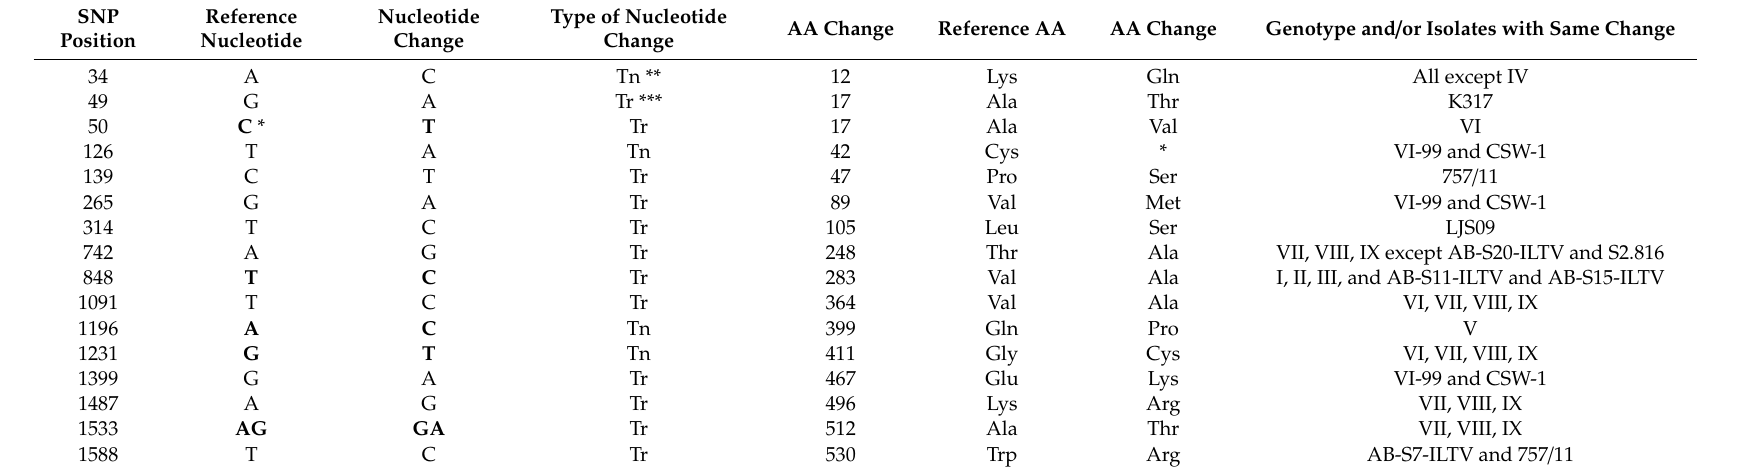
Table 2. Single nucleotide polymorphisms and amino acid change in reference strains and processed samples compared to LT-Blen (CEO genotype) as reference. Changes are recorded as shared with all samples that are classified into a specific genotype or as being present in specific